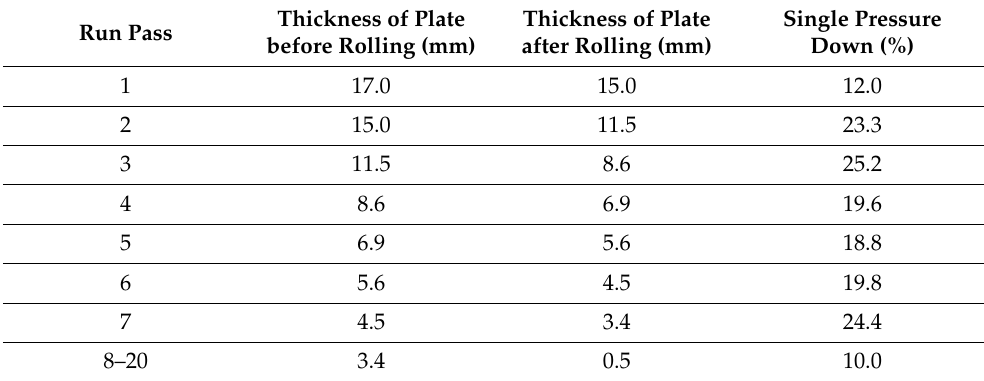
Table 2. Multipass-rolling experiment of ZK61 magnesium-alloy